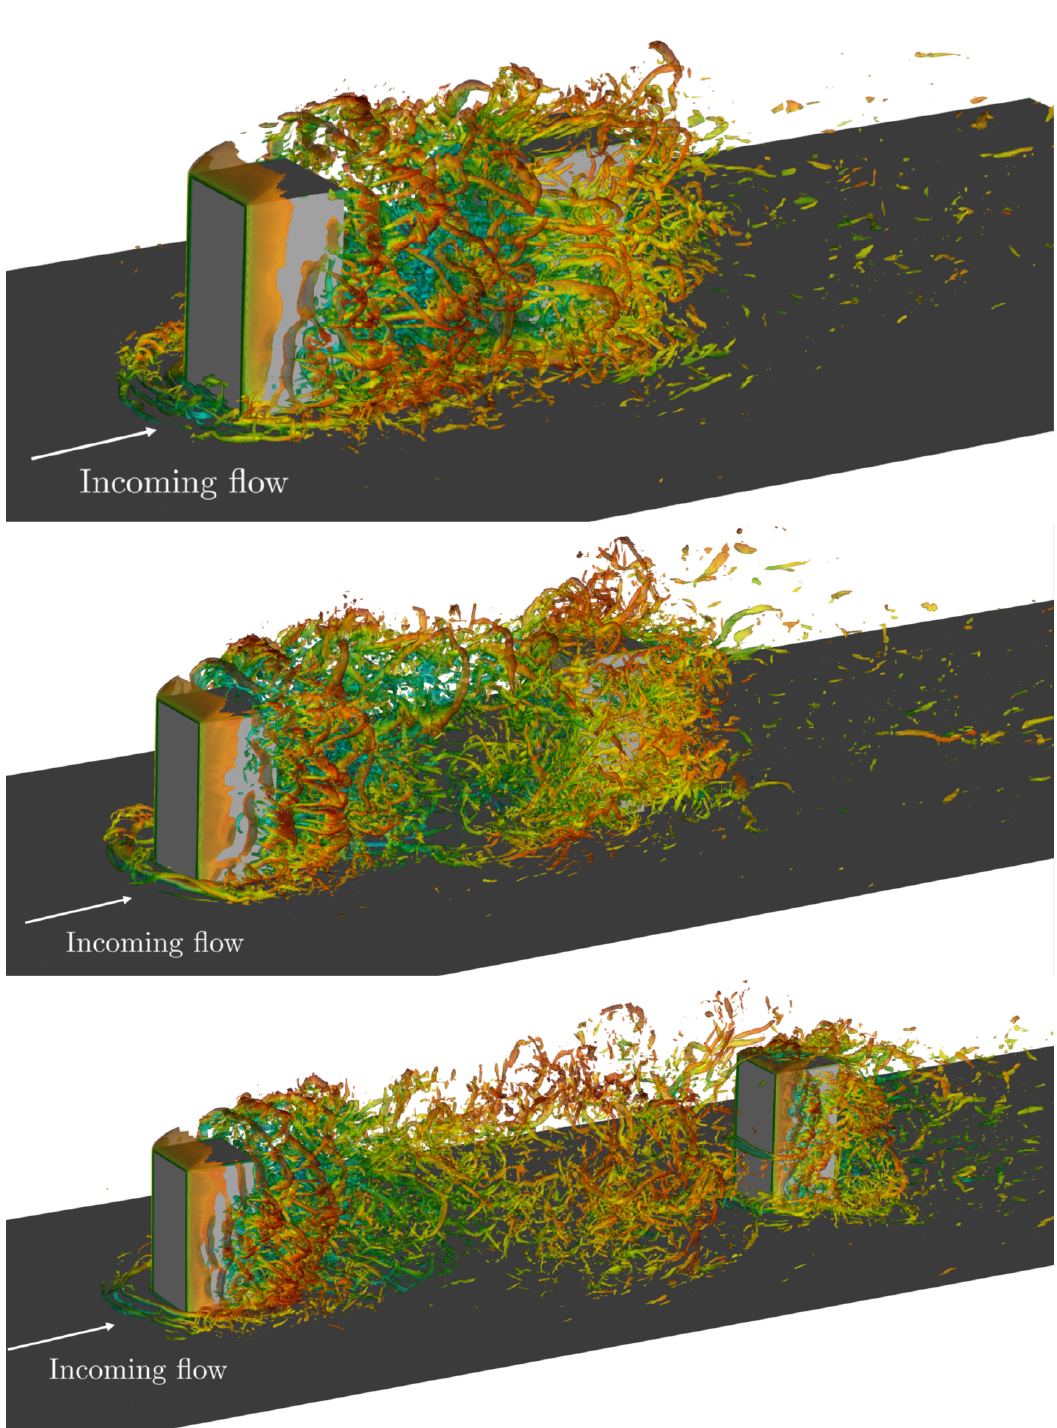
Figure 4. Instantaneous visualizations of the flow around two wall-mounted obstacles, showing vortical structures identified with the λ 2 method [22], with an isosurface of − 40 (scaled in terms of U ∞ and h ). The flow exhibits three regimes depending on the obstacle separation, according to the classification by Oke [18]: ( top ) skimming flow, ( middle ) wake interference and ( bottom ) isolated roughness. The structures are colored by streamwise velocity, ranging from (dark blue) − 1.2 to (dark red)